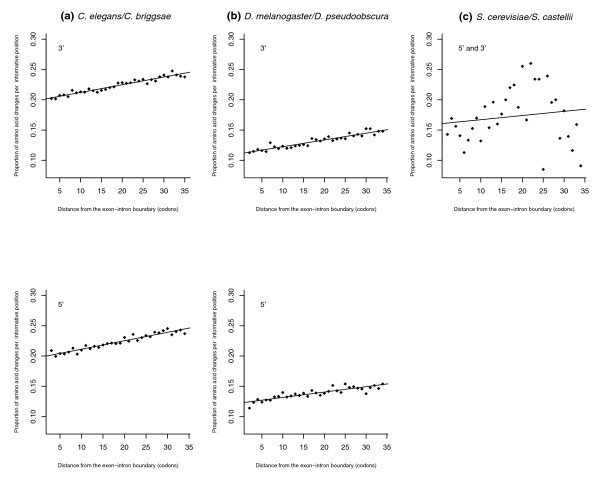
Frequency of nonsynonymous change as a function of distance from the exon-intron boundary. Amino acids are significantly more likely to be conserved near the exon-intron boundary comparing (a) C. elegans-C. briggsae (5', rho = 0.957, P = 0; 3', rho = 0.96. P = 0; N = 19,347 exons) and (b) D. melanogaster-D. pseudoobscura (5', rho = 0.87, P = 1.02E-07; 3', rho = 0.95, P = 0; N = 7,545 exons). The trends appear approximately monotonous and linear. Location-dependent conservation levels also appear slightly higher near the boundary comparing (c) S. cerevisiae-S. castellii but this is not significant (5', rho = 0.11, P = 0.55, N = 51; 3', rho = 0.11, P = 0.55, N = 39; pooled 3'/5', rho = 0.12, P = 0.51, N = 90) or of comparable monotony (but see Additional data file 9).